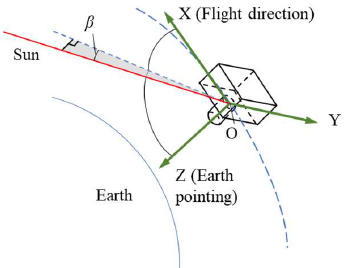
Figure 9. The relationship between solar vector and the camera coordinate system.